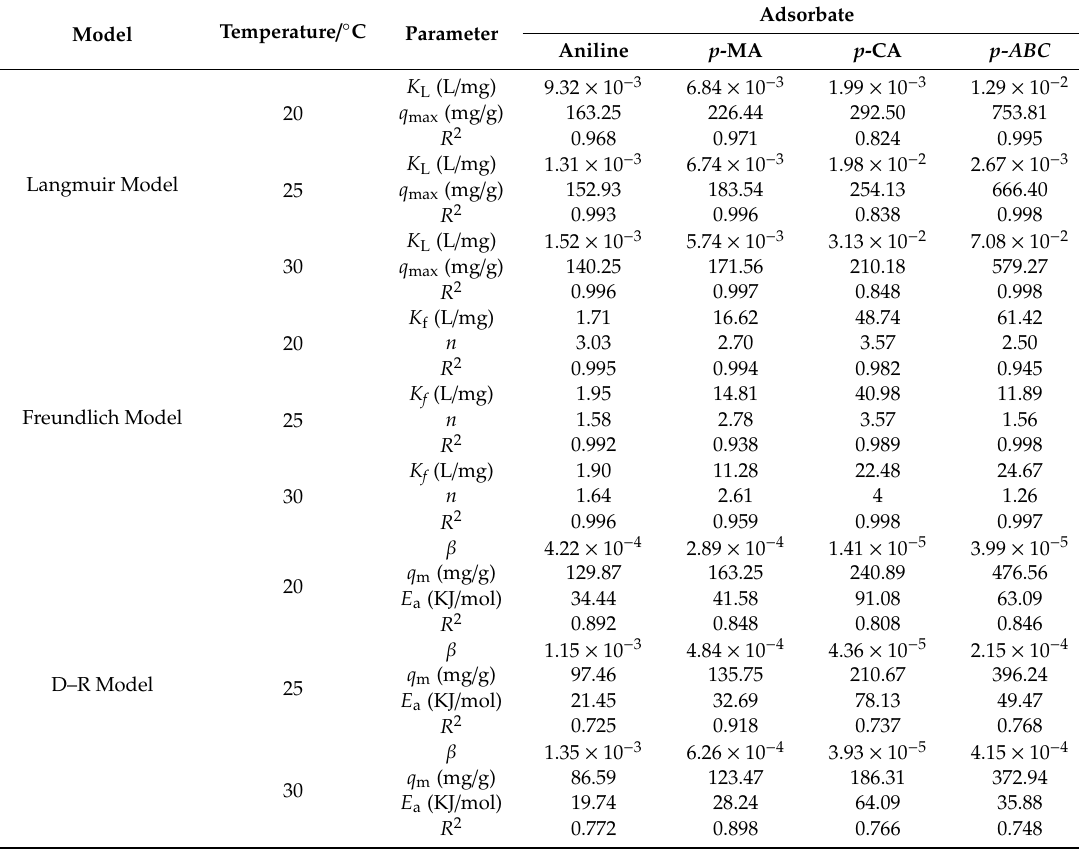
Figure 9. Isotherm model curves for the adsorption of aniline ( a ), p -MA ( b ), p -CA ( c ) and p -ABC ( d ) on the CDM-HCP; solid line is the Langmuir model and dashed line is the Freundlich model. Table 2. Calculated parameters of Langmuir, Freundlich, and Dubinin–Radushkevich (D–R) Models for the adsorption of